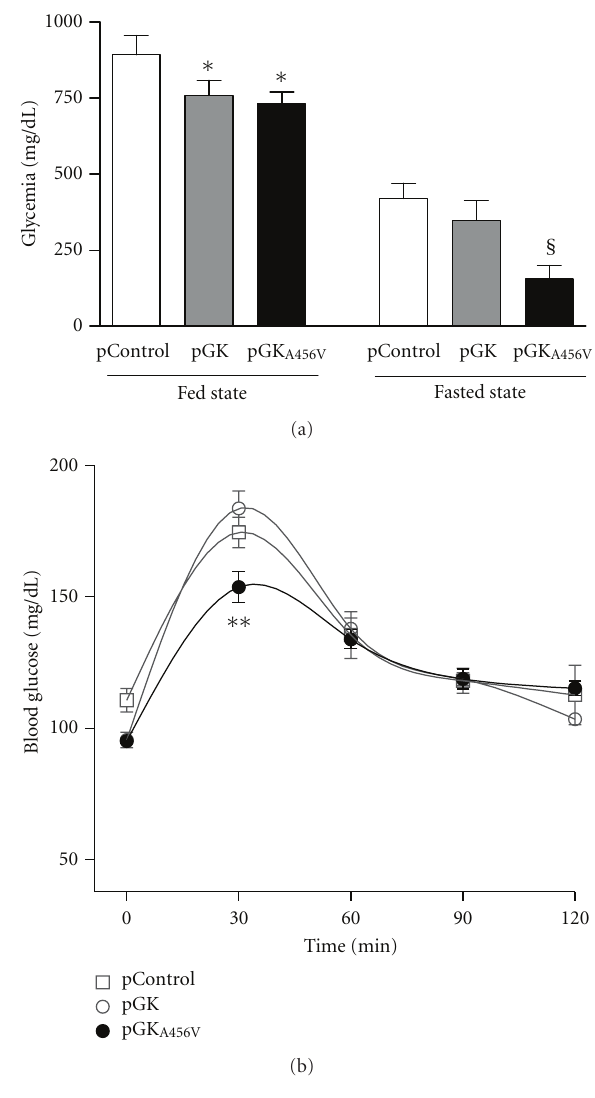
Figure 3: Blood glucose homeostasis in GK- and GK A456V -treated mice. Streptozotocin-induced diabetic mice were hydrodynamically injected with of pControl, pGK or pGK A456V . (a) Blood glucose levels were determined 48h posttransfection in fed state and after a 5-hour fast. Values are the mean ± SE ( N = 5–12, ∗ P < 0 . 05 versus pControl, § P < 0 . 05 versus pControl and versus pGK). (b) Glucose tolerance test in overnight fasted, healthy mice transfected with pControl, pGK, or pGK A456V . ∗∗ AUC versus pControl and